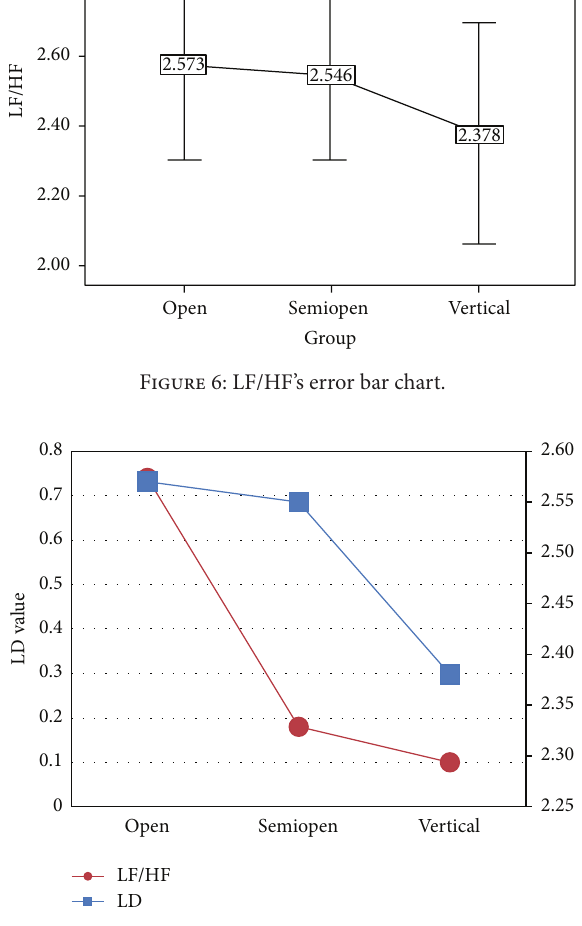
Figure 7: Relationship between LF/HF and LD.